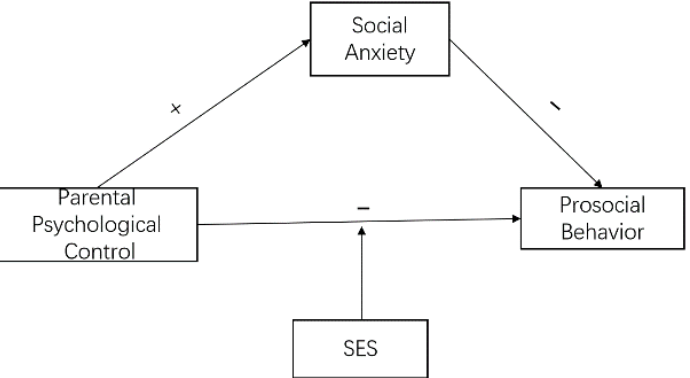
Figure 1. Research hypothesis